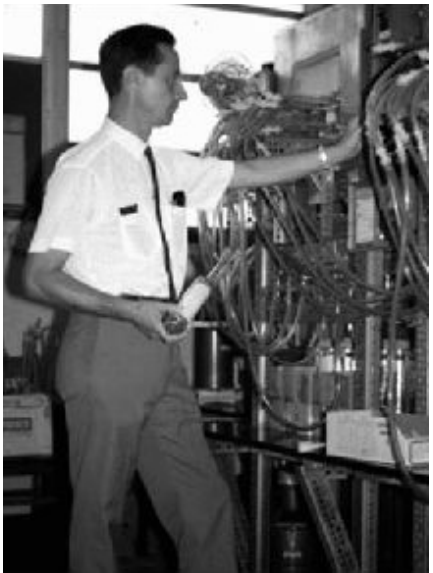
Figure 11. H. Göte Östlund preparing a gas sample for low-level counting analysis